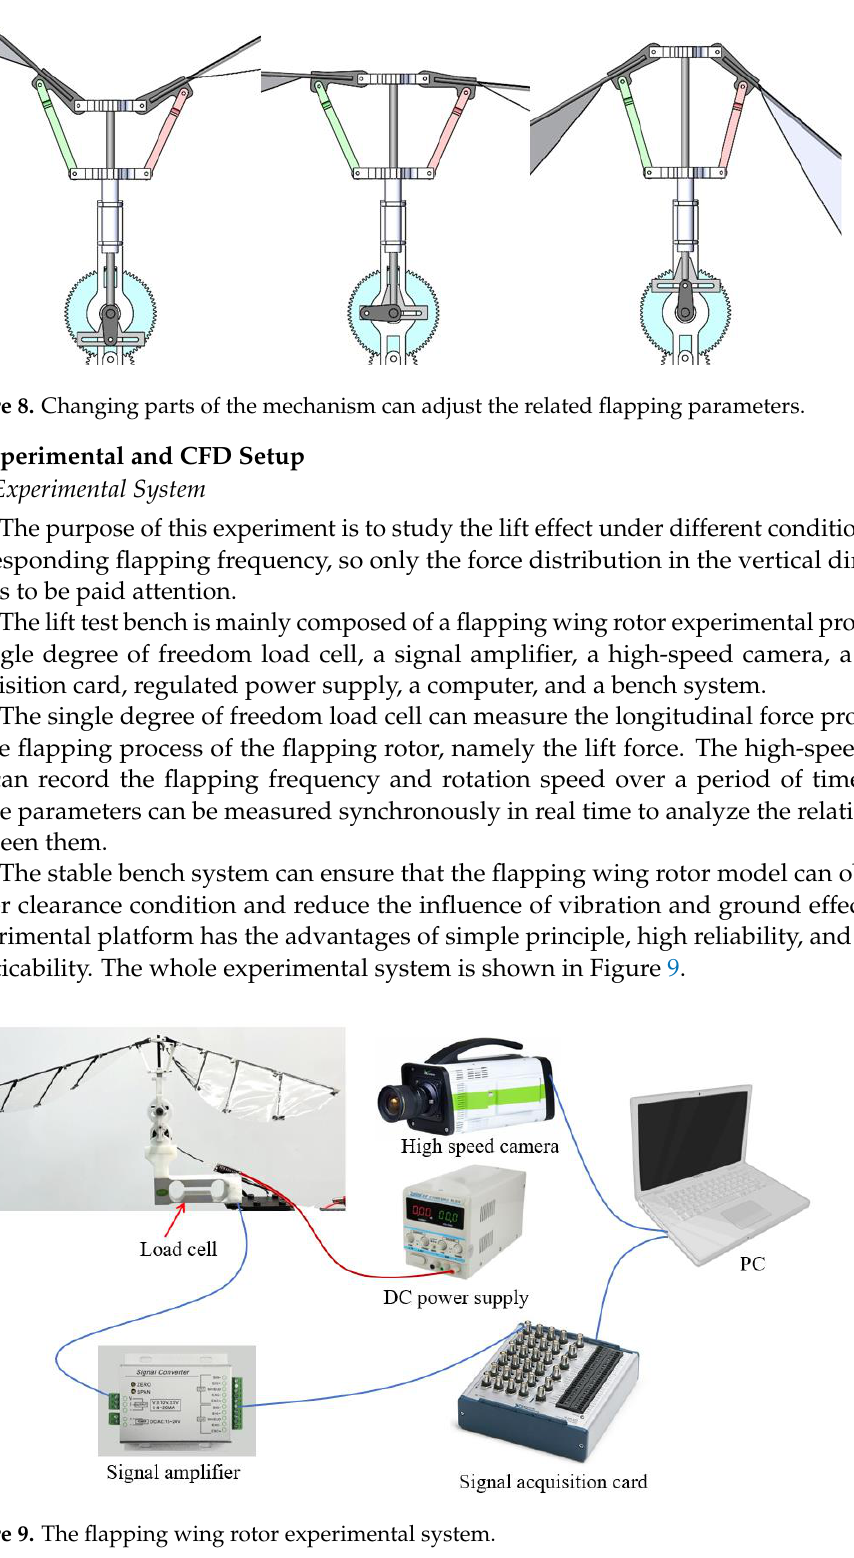
Figure 7. Flapping rotary mechanism.